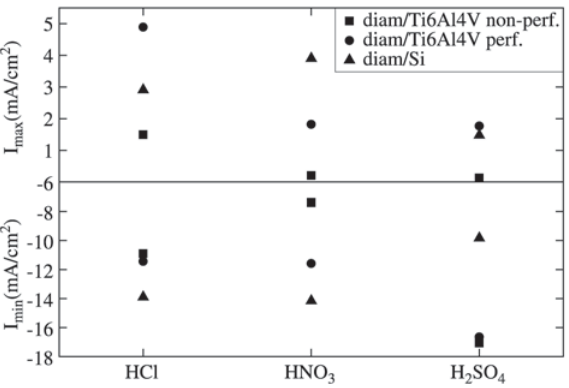
Figure 4. Current density in 0,1 M acid solutions.